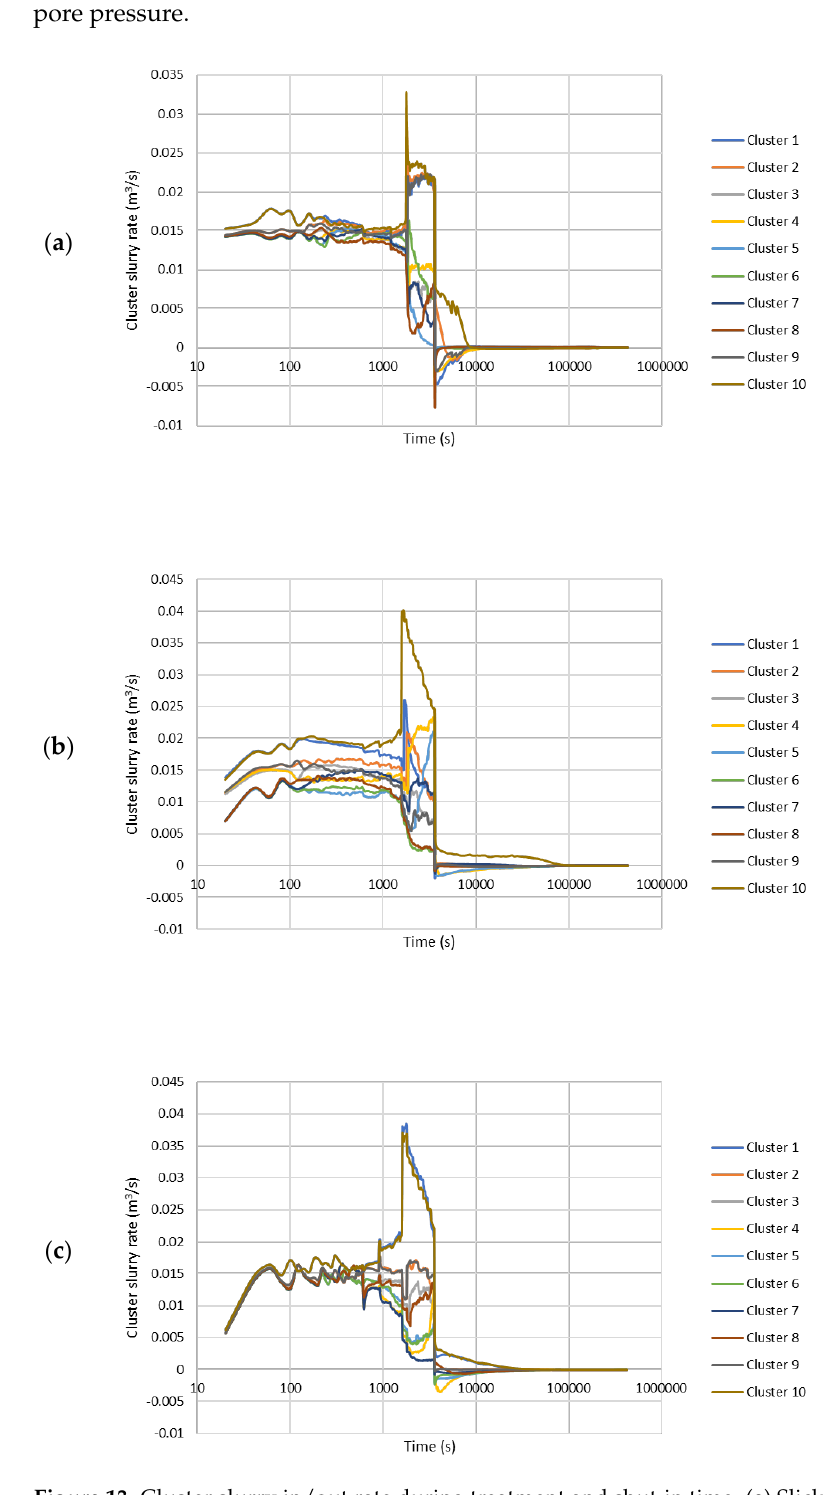
Figure 13. Cluster slurry in/out rate during treatment and shut-in time. ( a ) Slick water case. ( b ) NG foam case. ( c ) Hybrid NG and HG foam case.